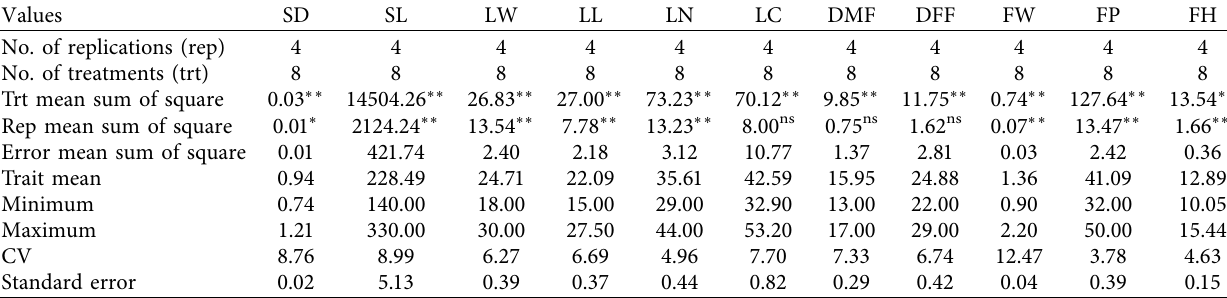
Table 1: Analysis of variance for agronomic and fruit characteristics of melon varieties. Values